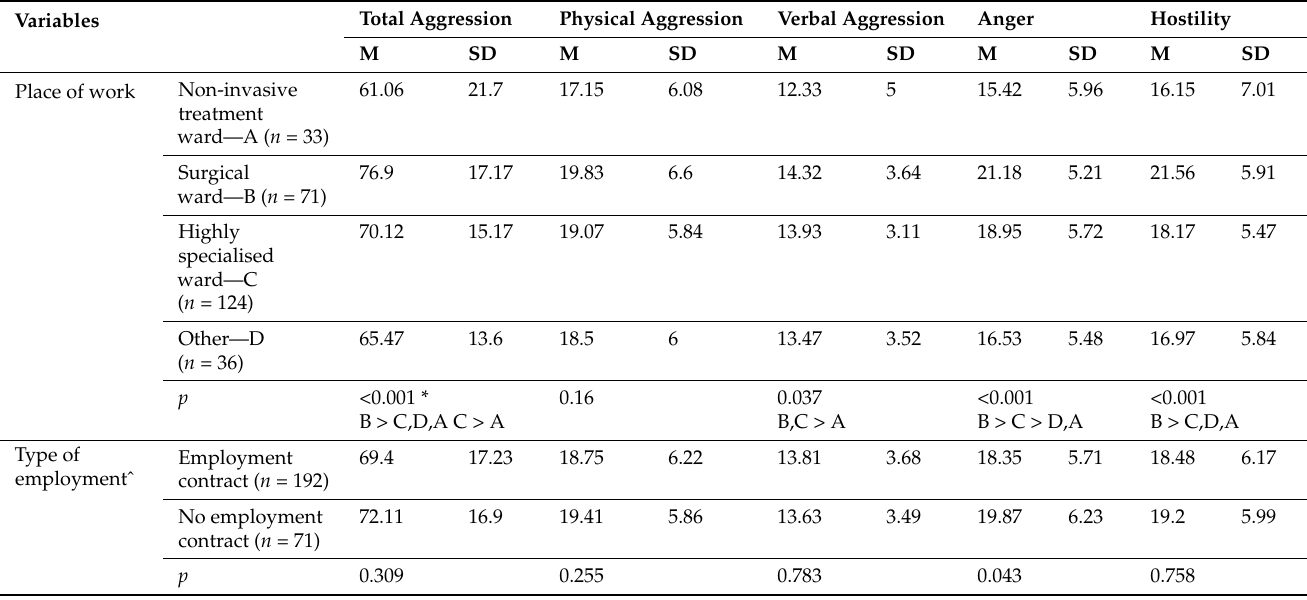
Table 8. The effect of work-related variables on aggression.